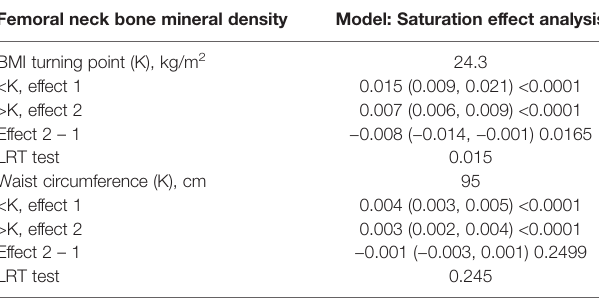
TABLE 4 | Saturation effect analysis of BMI (kg/m 2 ) and waist circumference (cm) on femoral neck BMD (g/cm 2 ) of all participants. Femoral neck bone mineral density Model: Saturation effect analysis